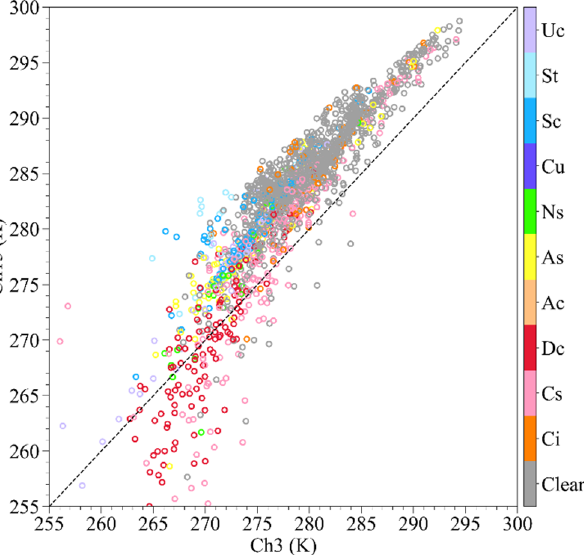
Figure 3. Scatterplot of BT (unit: K) observed by NOAA-19 AMSU-A channels 3 and 15 in East Asia at 0600 UTC 26 June 2019. The colors of the circles indicate the matched simultaneous MODIS cloud classification products.